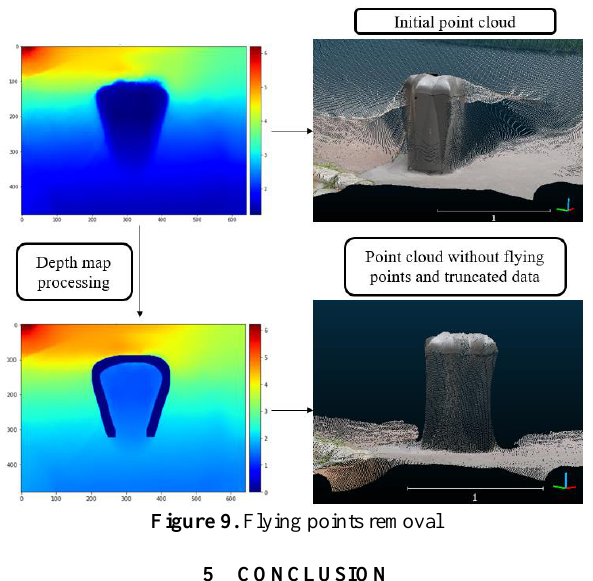
Figure 9. Flying points